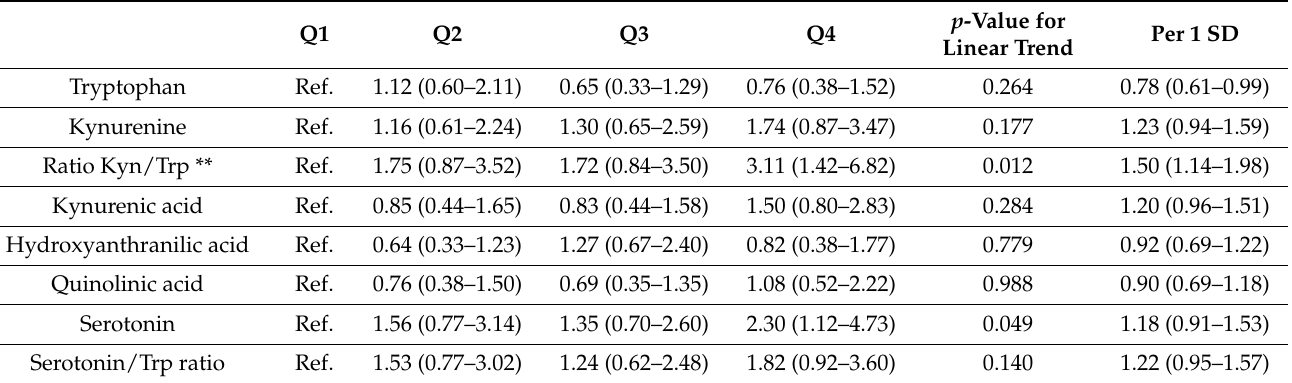
Table 3. Association * between plasma tryptophan–kynurenine/tryptophan–serotonin pathway metabolites and incident peripheral artery disease